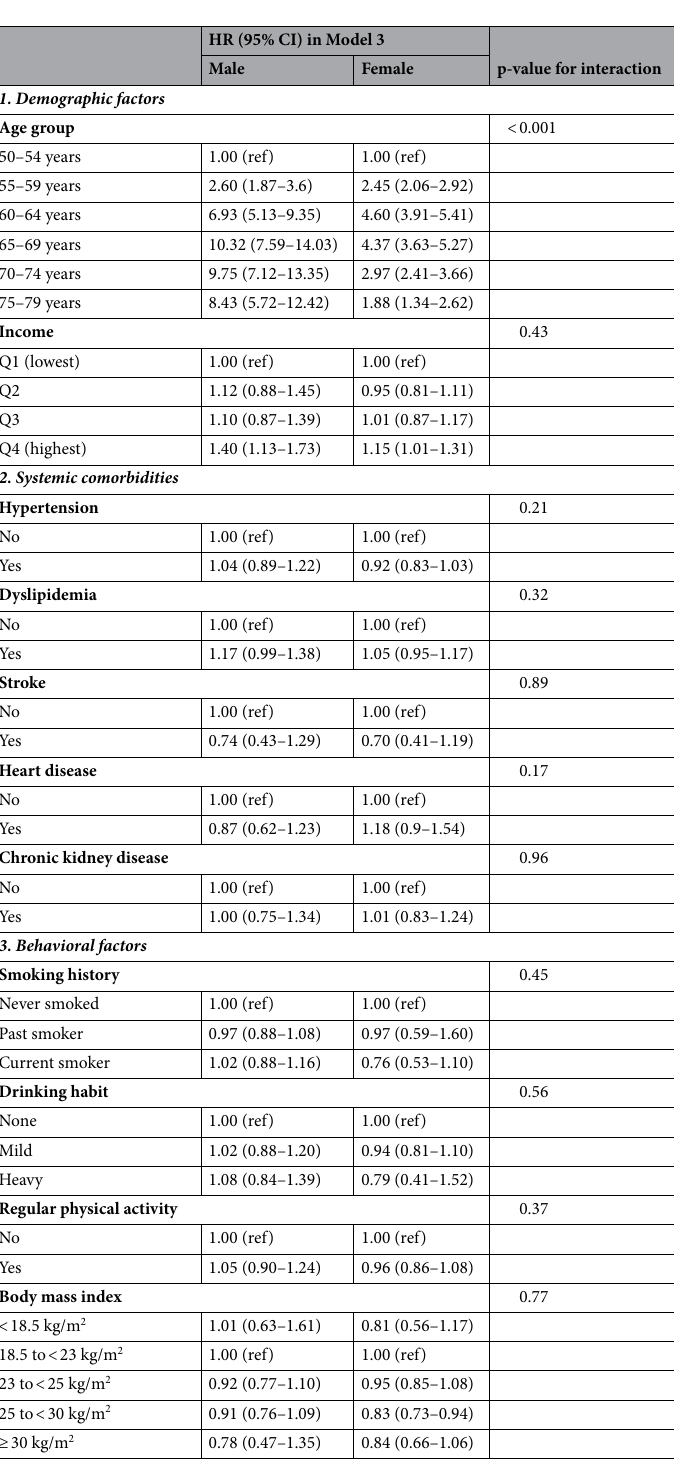
Table 3. Hazard ratios and 95% confidence intervals for risk factors associated with idiopathic macular hole development according to sex and its interaction with other covariates. HR hazard ratio, CI confidence interval, Q quartile. Model 3: adjusted for demographic factors (age, sex, income level), systemic comorbidities (hypertension, dyslipidemia, stroke, heart disease, chronic kidney disease), and behavioral factors (smoking history, drinking habit, physical activity, body mass